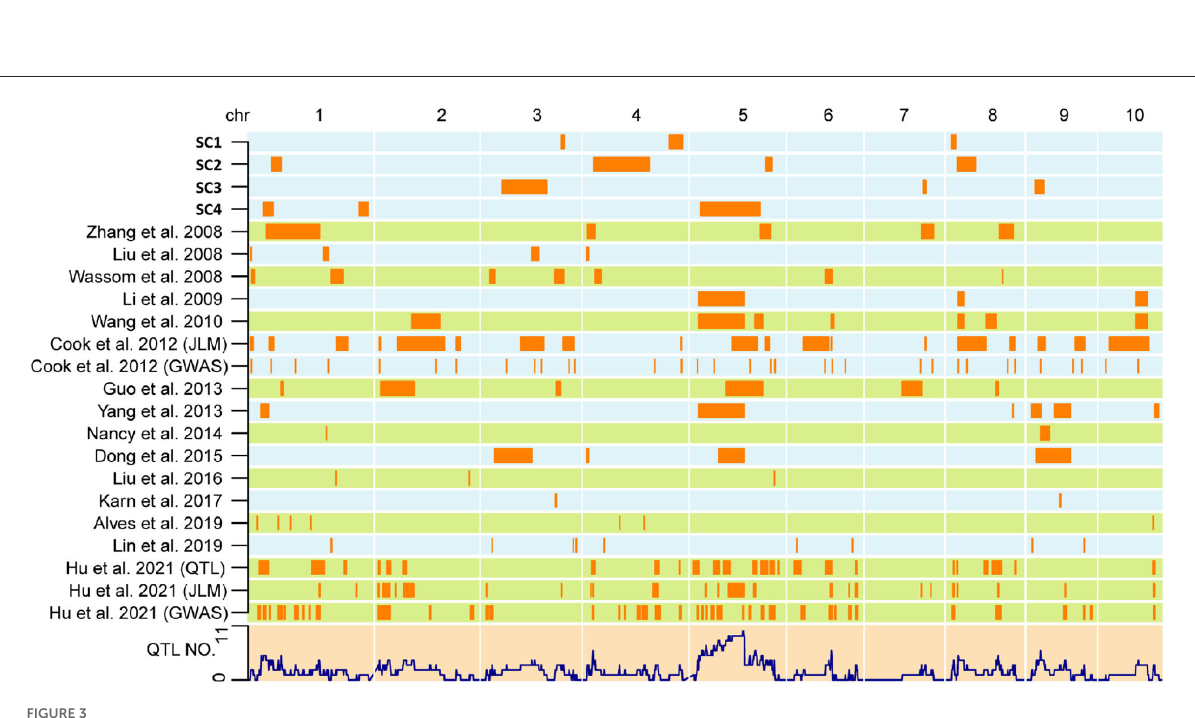
FIGURE3 Co-localization of SC QTLs in maize kernels identified in the current and previous studies. The QTLs identified in the four DH populations are represented on top. QTLs detected in previous studies are displayed in the form of references. The lower layer shows the number of detected